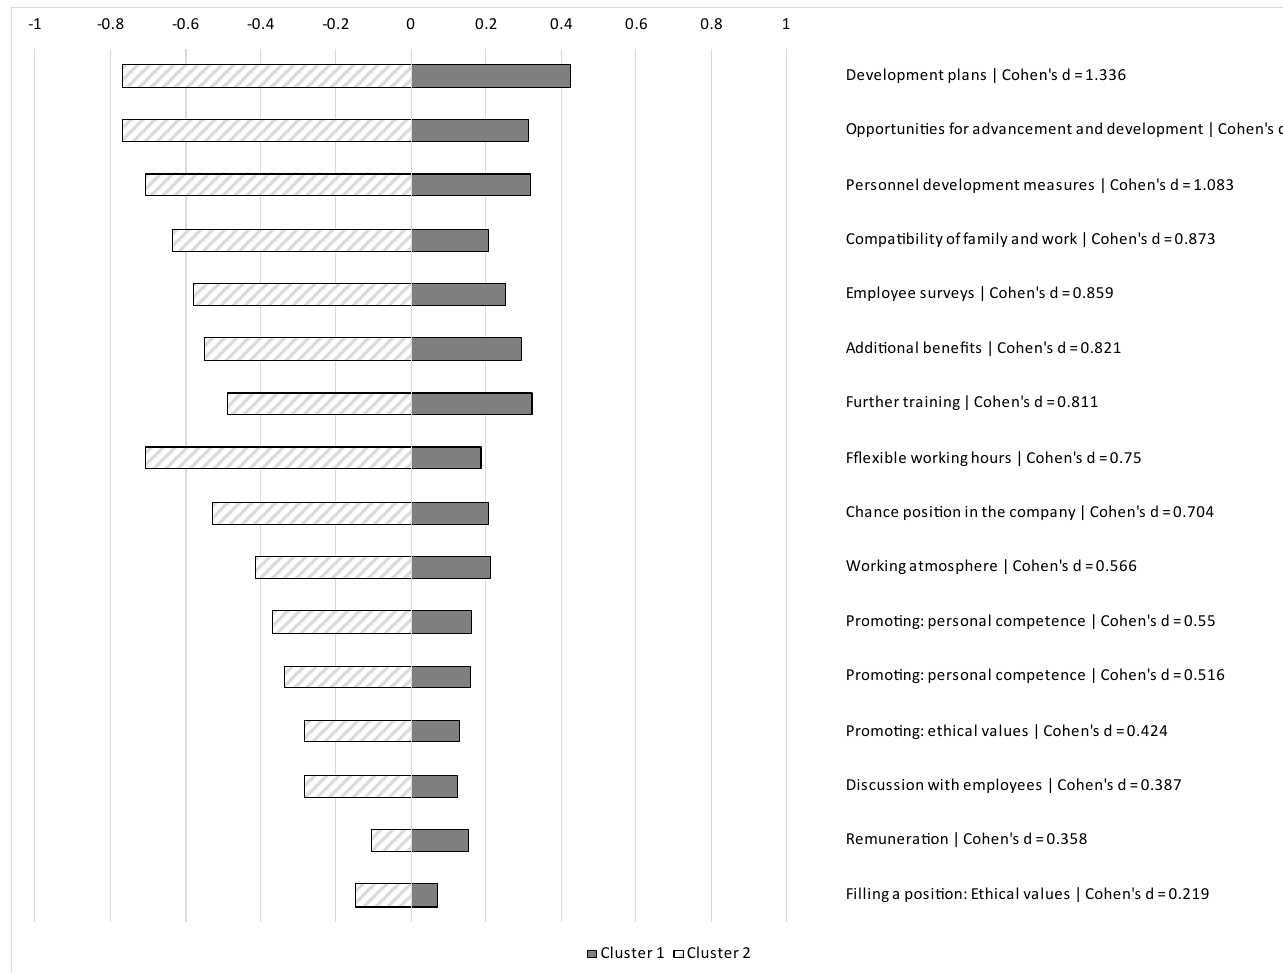
Figure 1. Results of the cluster analysis based on the HR management survey. Mean values of the z-scores for both clusters; Cluster 1: n = 7378, Cluster 2: n = 3569.